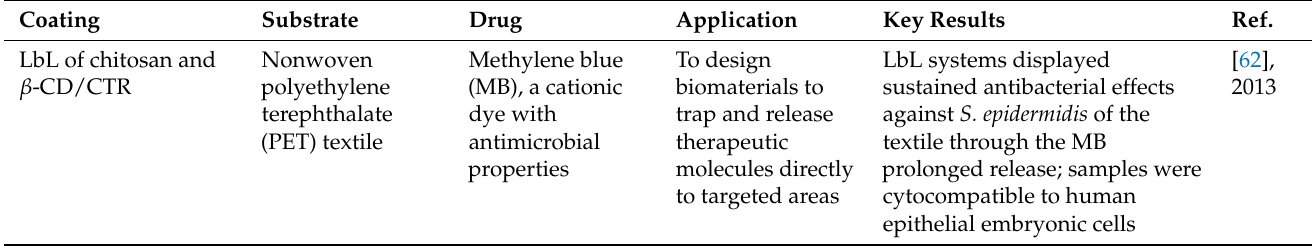
Table 4. Applications of coatings of cyclodextrin/citric-acid biopolymers as drug-delivery systems (Part 2).